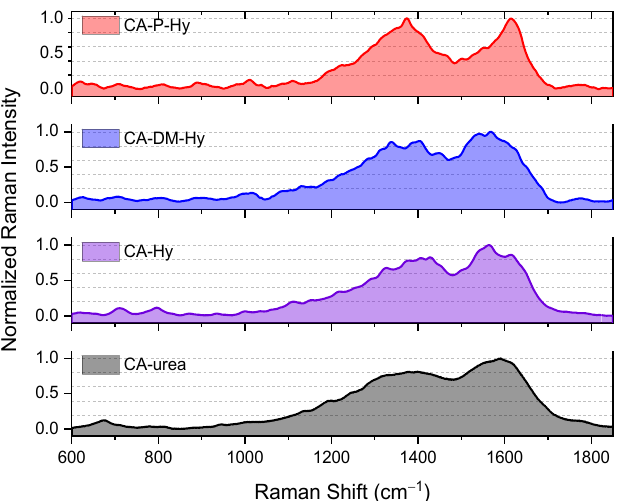
Figure 5. Raman spectra of the hydrazine-based compounds compared to urea-derived CDs.